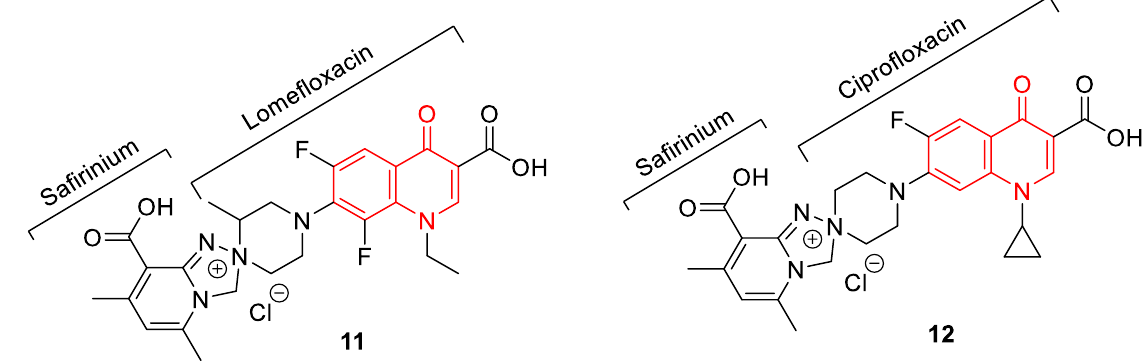
Table 2. Computational studies with DNA gyrase isolated from Escherichia coli (PDB: 2XCT) imply that the newly synthesized hybrids ( 13 ) strongly interact with both gyrase subunits